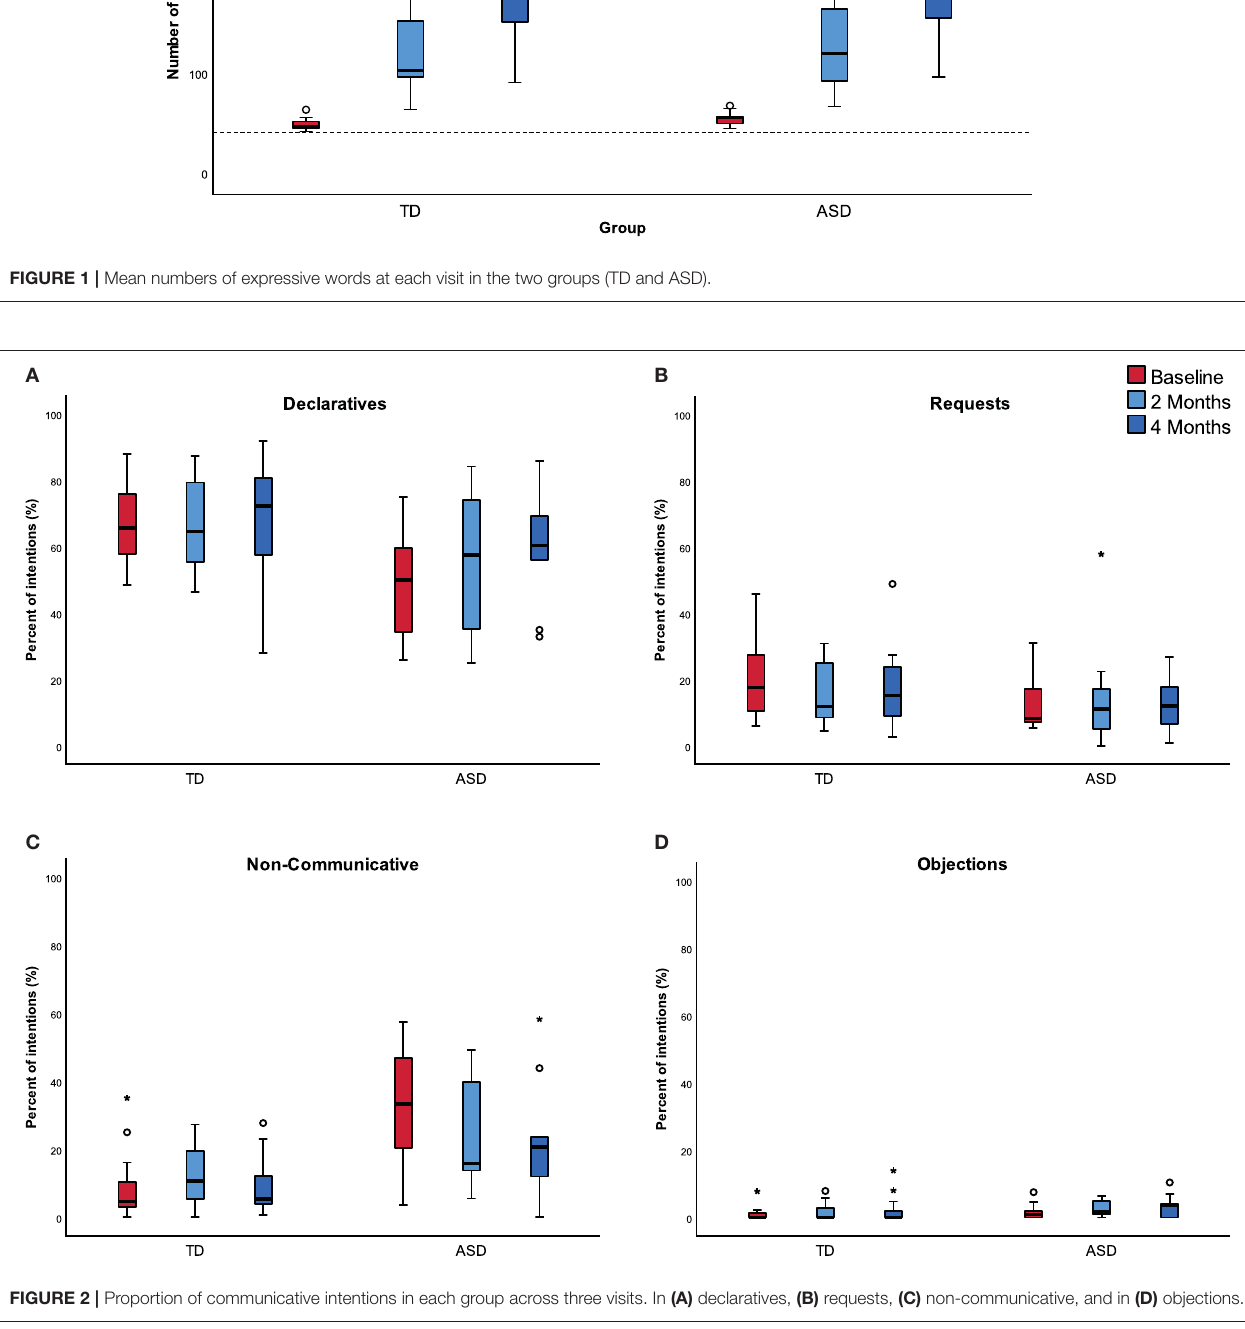
Frontiers in Neurology |